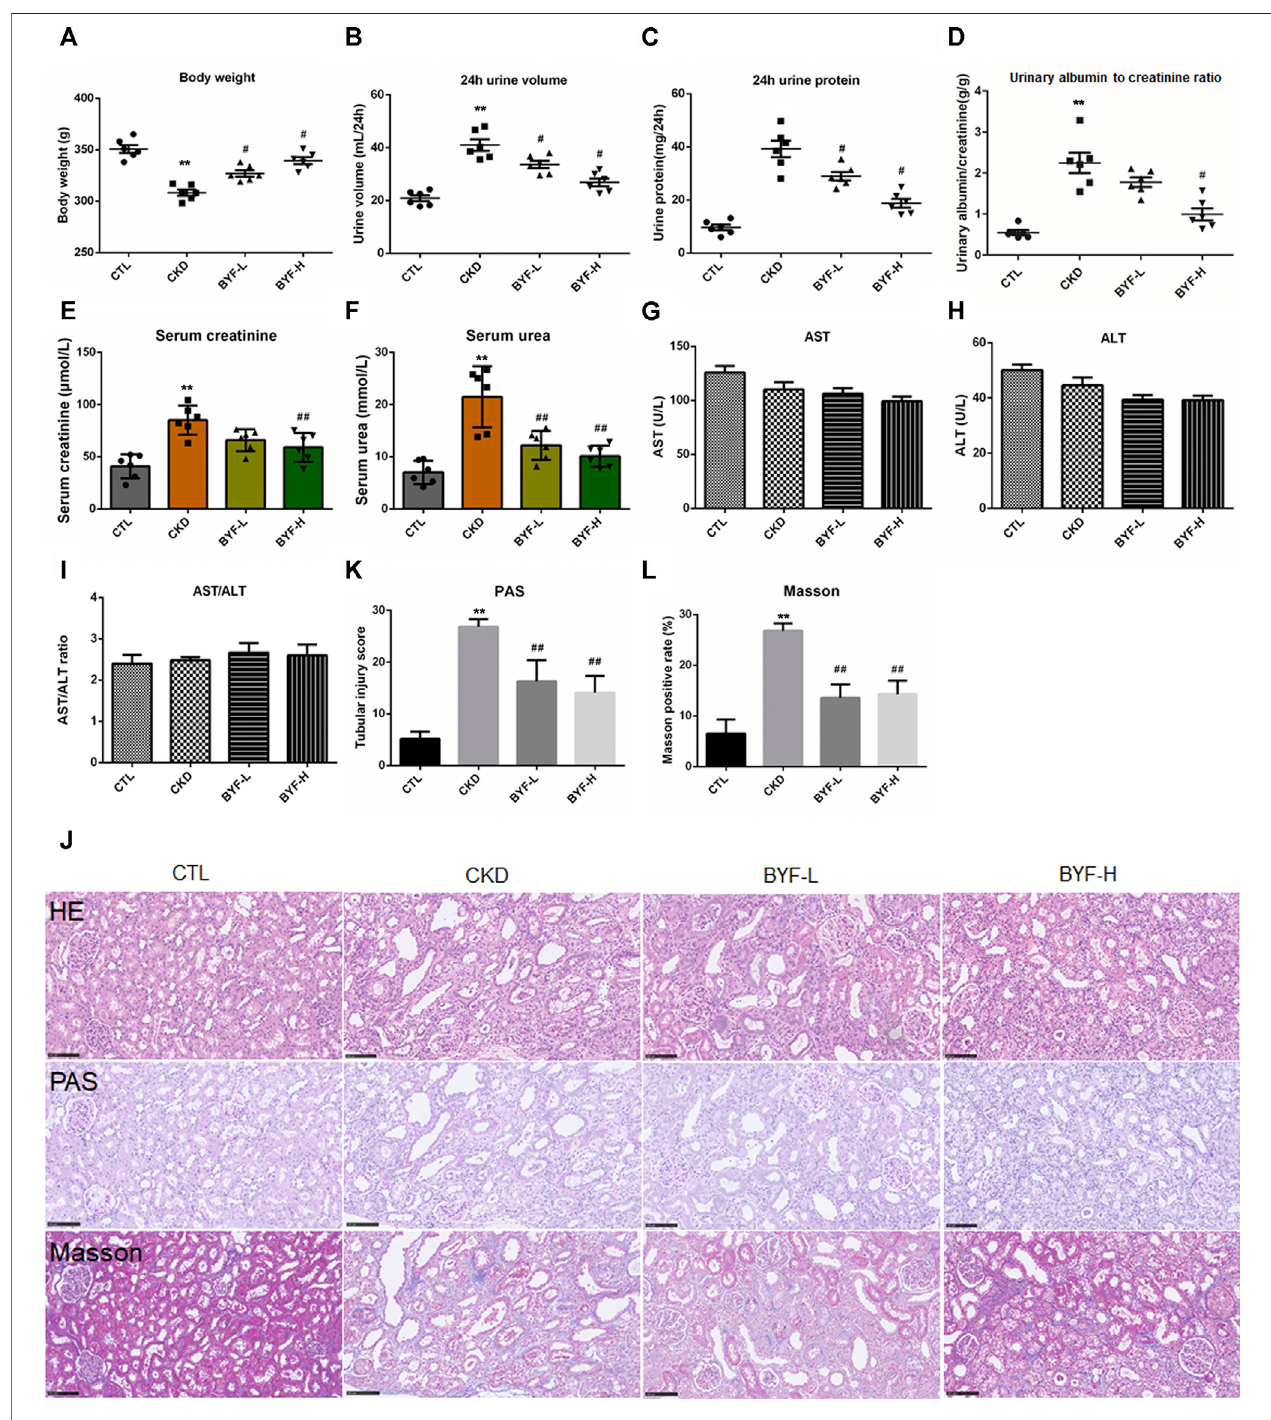
FIGURE3| BYFimproveskidneyfunctionandreducesrenalpathologicalinjuryinadenine-inducedCKDrats.BYFadministrationeffectivelyincreasedbodyweight (A) and reduced urine volume (B) . In CKD rats, BYFreduced 24 h urinary protein excretion (C) , urinary albumin-to-creatinine ratio (D) , serum creatinine (E) and urea (F) . (G) SerumALT, (H) AST, (I) andALT/ASTlevels. (J) HE,PAS,andMasson ’ strichromestainingrepresentativemicrographsinindicatedgroups(scalebar (cid:1) 100 μ m). (K) Chronic tubular atrophy score. (L) Quantitative analysis of Masson trichromatic positive rate. All values were presented as means ± SD. n (cid:1) 6 rats per group. * p < 0.05 and ** p < 0.01 vs. the CTL group; # p < 0.05 and ## p < 0.01 vs. the CKD group.